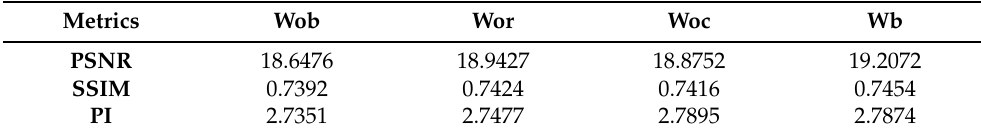
Table 7. Quantitative comparisons with different loss functions on NTIRE dehazing challenge datasets. ’wob’, ’wor’, ’woc’ and ’wb’ denote without both losses, without registration loss, without contrastive loss and with both losses, respectively.